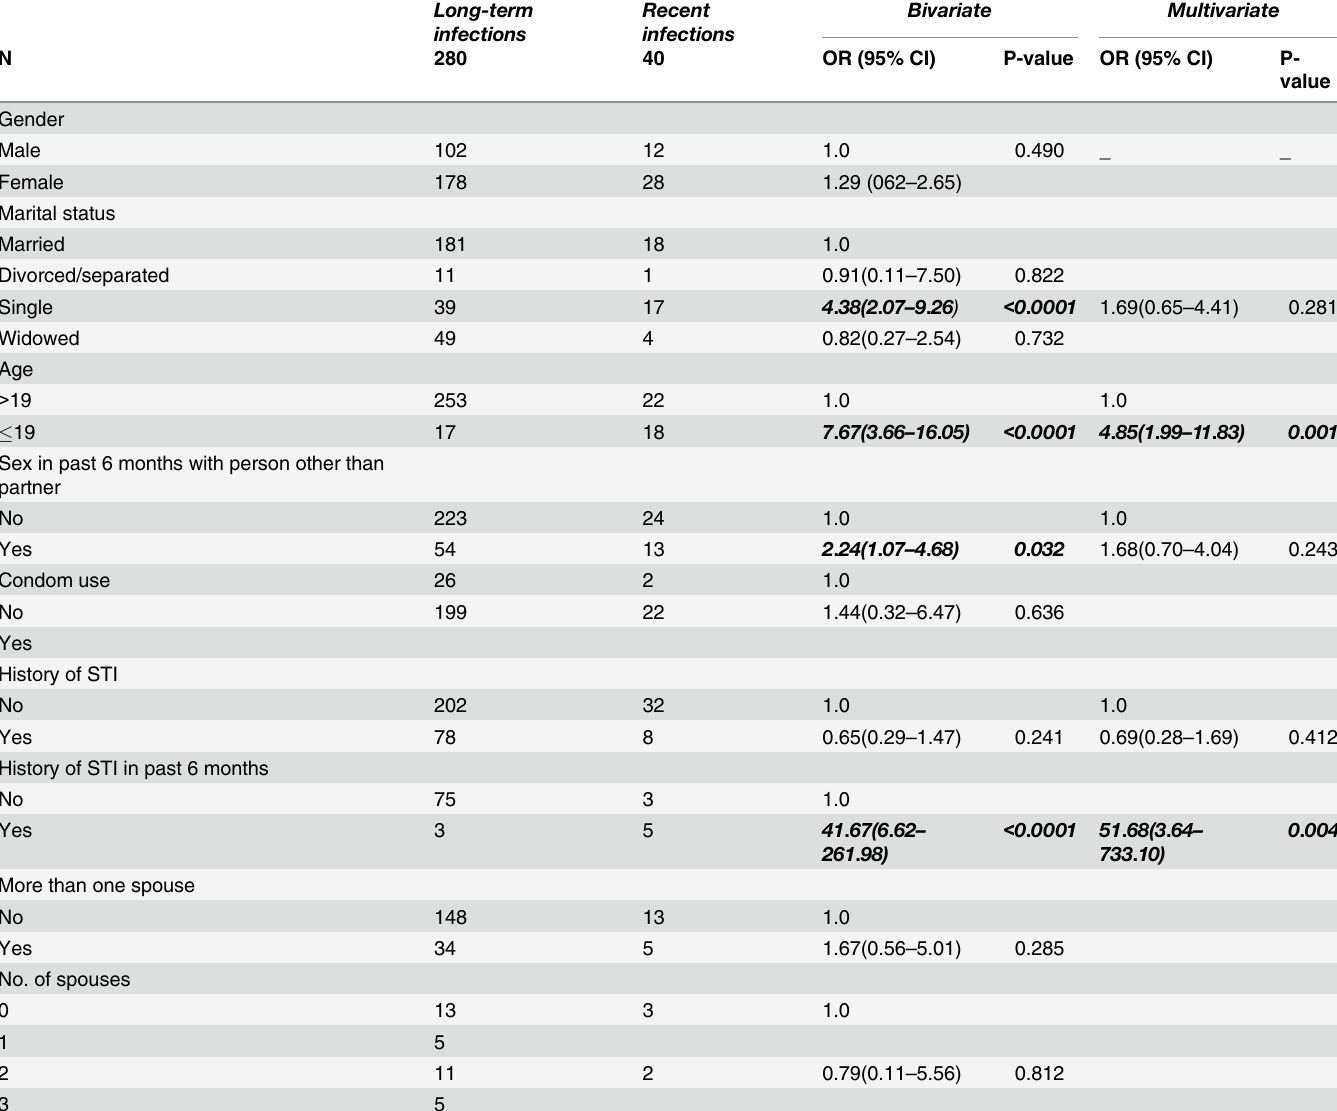
Table 2. Unadjusted and Adjusted Odds ratios and 95% CI for factors associated with recent infections among HIV-1 positive participants in West- ern Kenya, October 2003 – May